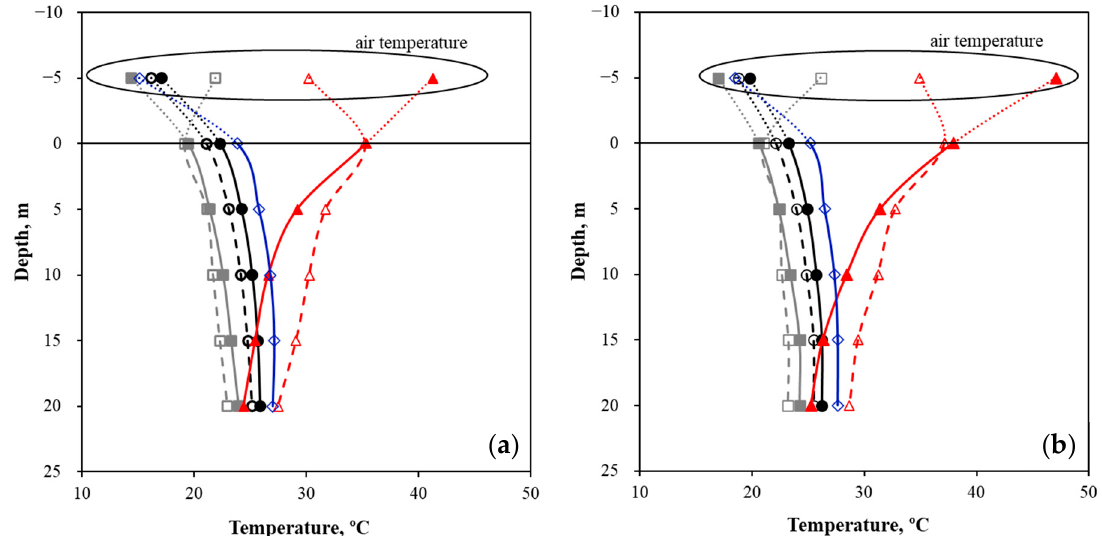
Figure 8. Soil temperature profile without low tunnel ( a ) and with tunnel ( b ) at different times on the third day of the test (5 March 2015): at 0:00 ( ● ), 2:00 ( ○ ), 6:00 ( ■ ): 10:00 ( □ ), 14:00 ( ▲ ), 18:00 ( Δ ), and 22:00 ( ◊ ) hours.